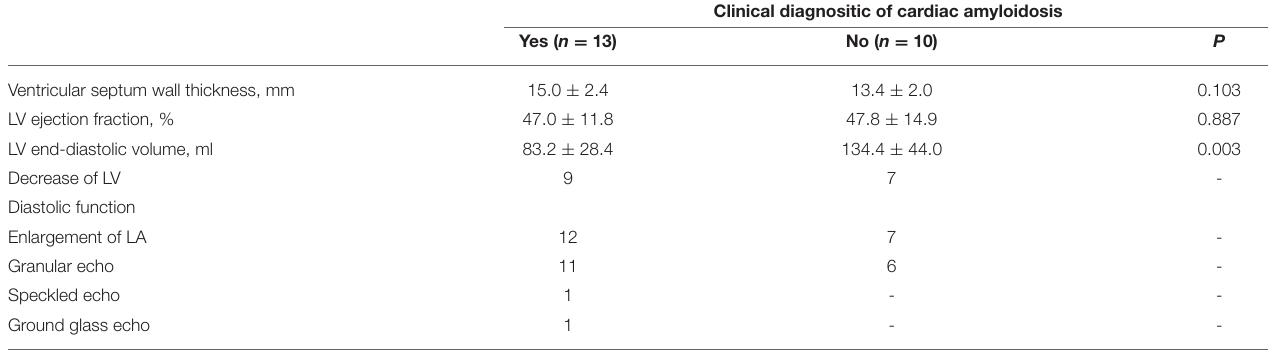
TABLE 3 | Echocardiography data from CA patients and non-CA